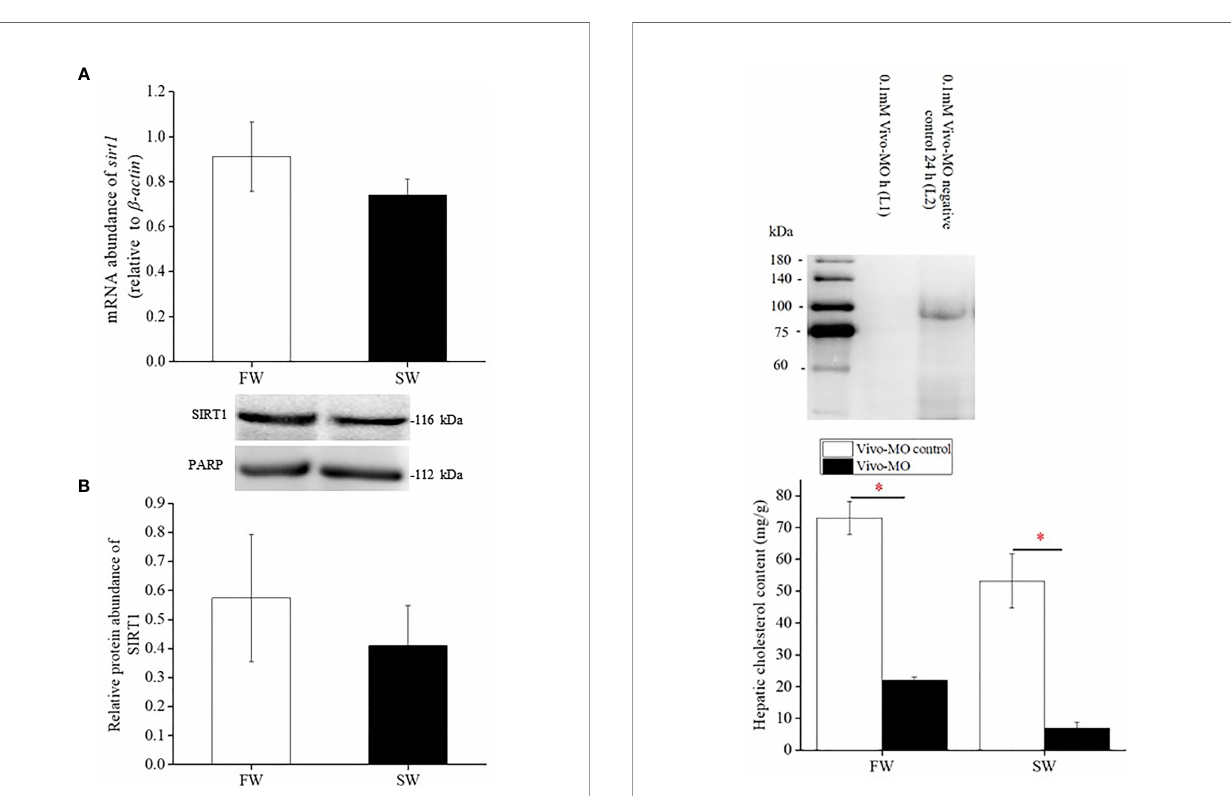
FIGURE 4 | Relative gene (A) and protein (B) expression of SIRT1 in livers of fresh water (FW) and seawater (SW)- acclimated Indian medaka. mRNA expression was analyzed by real-time PCR. The immunoblots were used to detect the protein expression. Values are mean ± S.E.M. (N = 6).